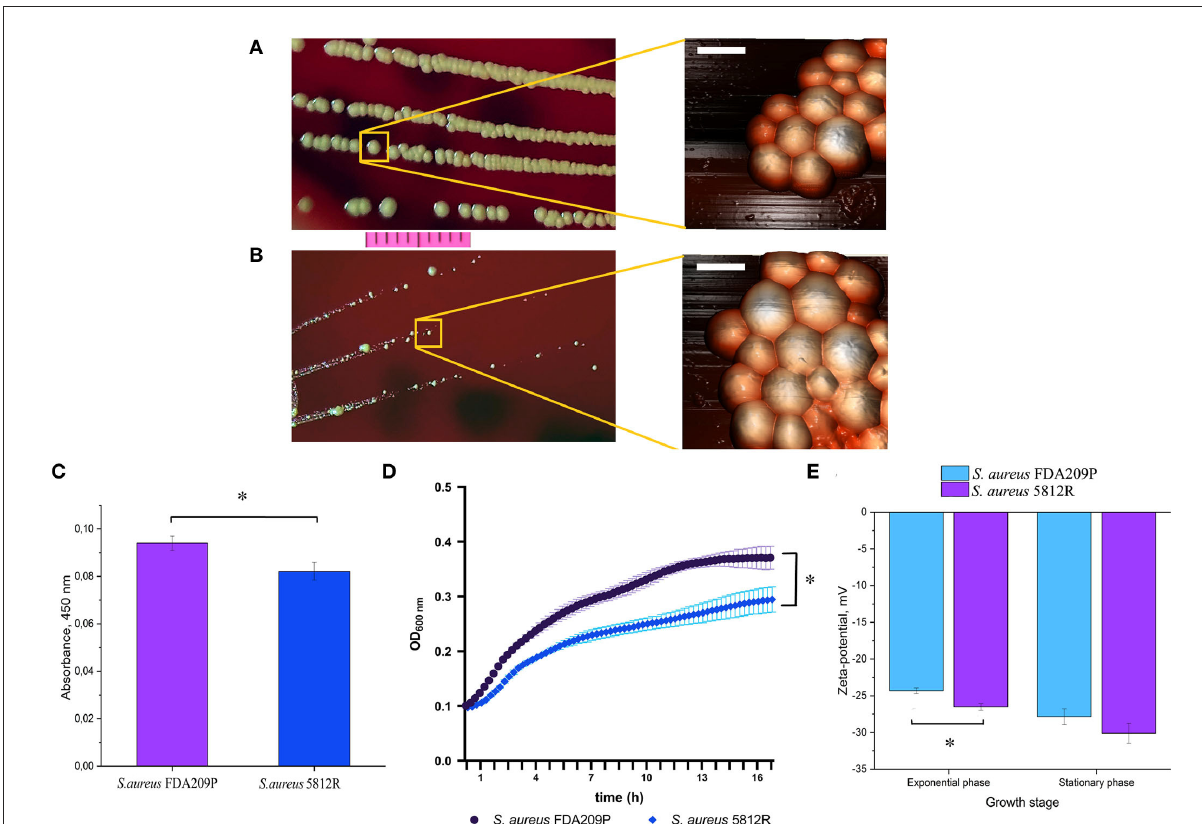
FIGURE1 The phenotypical characteristics of the gausemycin A-resistant S. aureus 5812R strain. Morphology of colonies and bacterial cells of S. aureus FDA209P (A) and S. aureus 5812R (B) , which were formed for 24h. Optical microscopy (bar- − 1cm) and atomic force microscopy (bar – 1 µ m) were used for revealing the morphology of bacterial colonies and cells, respectively. (C) The amount of pigment which was extracted from colonies and expressed in absorbance units. The means plus standard deviations of the means of results from three independent experiments with three technical replicates are shown ( * p < 0.05). (D) The growth kinetics of S. aureus FDA209P and S. aureus 5812R on Muller-Hinton medium without gausemycin A. (E) The charges of bacterial cells at various growth stages, which were estimated in zeta-values. The means plus standard deviations of the means of results from two independent experiments with three technical replicates are shown (* p <